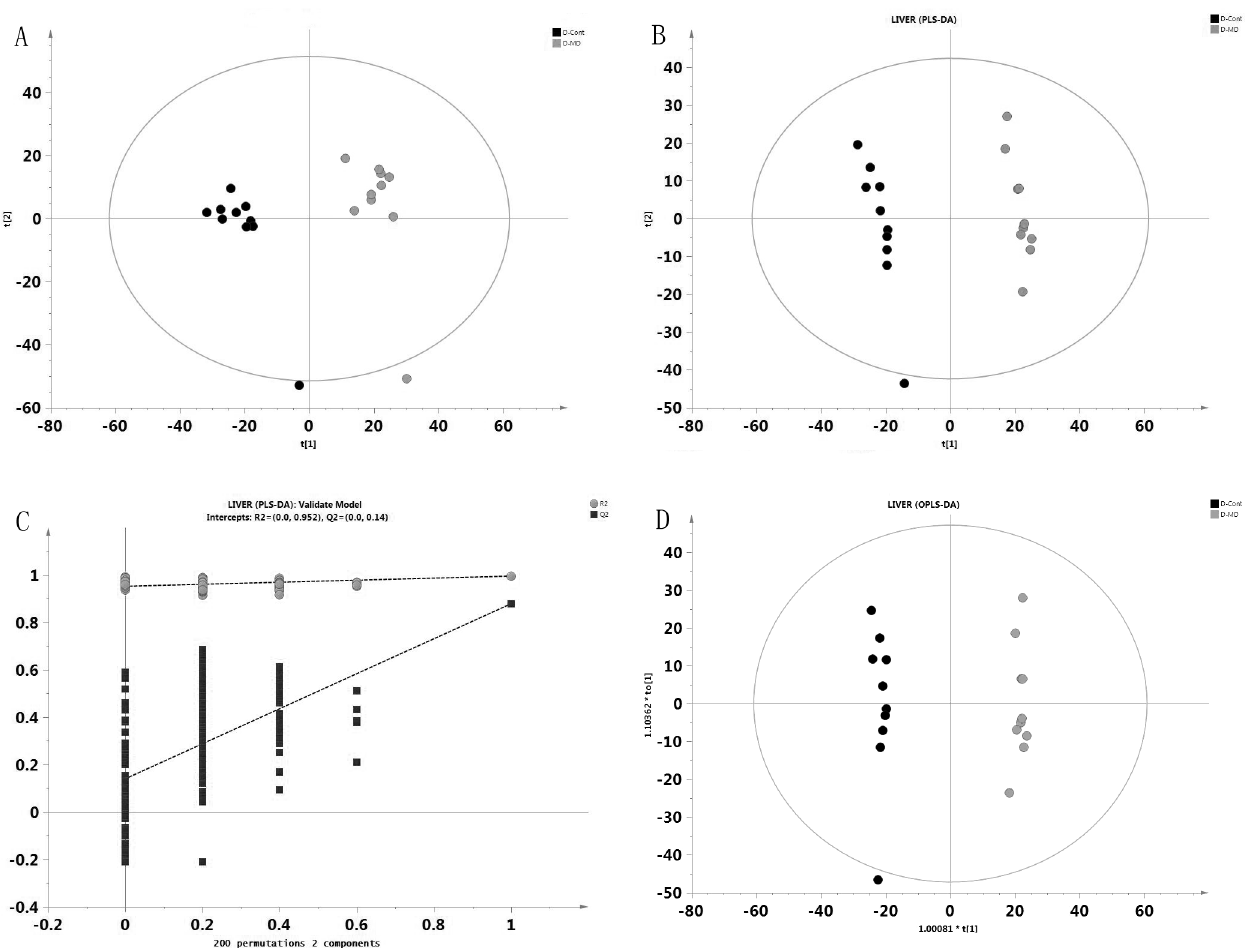
Fig 1. Multivariate statistical analysis of liver GC/MS data. A)Score plot of PCA obtained from control group( ● ) and D-galactose group( ● ). B)Score plot of PLS-DA obtained from control group( ● ) and D-galactose group( ● ). C) The result of permutation test, R2 (gray circle),Q2 (black square). D) Score plot of OPLS model obtained from control group( ● ) and D-galactose group( ● )